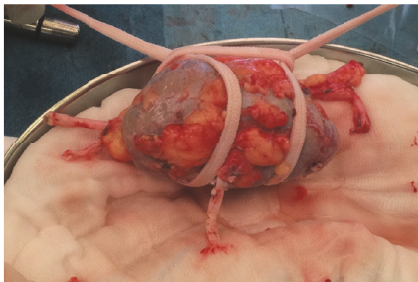
Figure 4: After end-to-side reconstruction of the middle polar artery and main renal